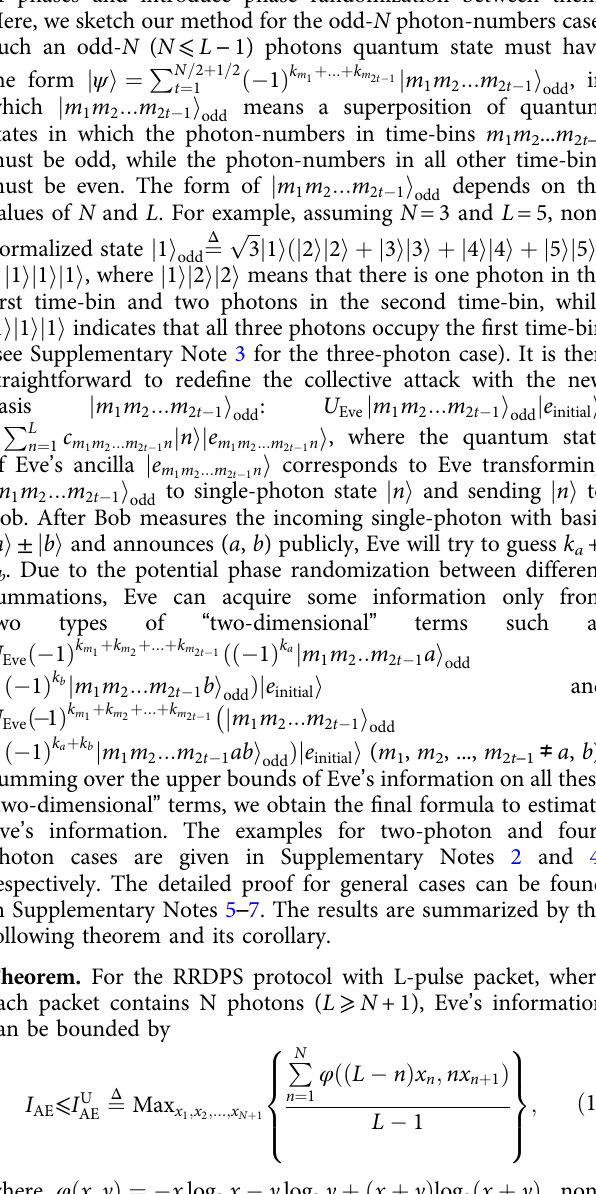
Table 1 E max of RRDPS with different